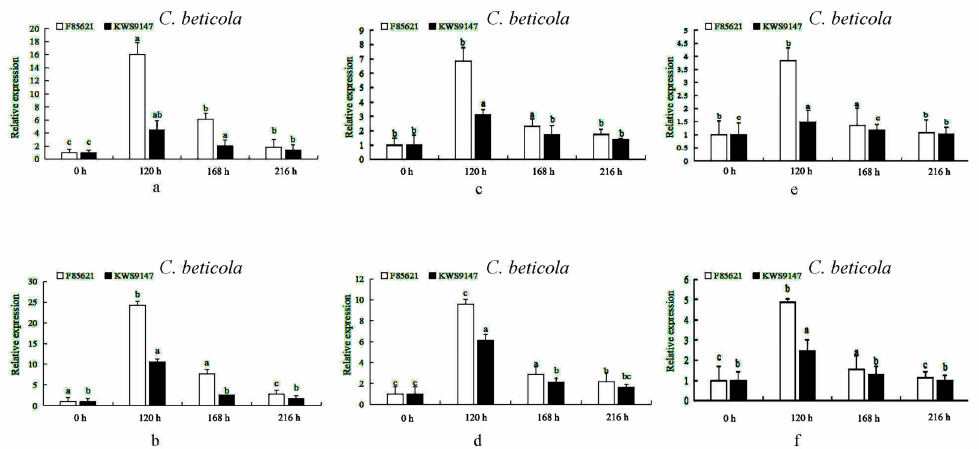
Figure 9. The relative expression of BvBTB1 , BvBTB2 , and BvBTB 3 after high and low spore con- centrations of C. beticola infection at different times in leaves in the resistant material ‘F85621’ and susceptible material ‘KWS9147’. X-axial represents the times of C. beticola infection in sugar beet, while Y-axial represents the relative expression of BvBTB in sugar beet materials ‘F85621’ and ‘KWS9147’ on C. beticola infection. ( a ) The relative expression of BvBTB1 in leaves at 0, 120, 168, 216 h in sugar beet resistant material ‘F85621’ and susceptible material ‘KWS9147’ after low spore concentrations of C. beticola with 7 × 10 6 spores/mL infection. ( b ) The relative expression of BvBTB1 in leaves at 0, 120, 168, 216 h in sugar beet resistant material ‘F85621’ and susceptible material ‘KWS9147’ after high spore concentrations of C. beticola with 16 × 10 6 spores/mL infection. ( c ) The relative expression of BvBTB2 in leaves at 0, 120, 168, 216 h in sugar beet resistant material ‘F85621’ and susceptible material ‘KWS9147’ after low spore concentrations of C. beticola with 7 × 10 6 spores/mL infection. ( d ) The